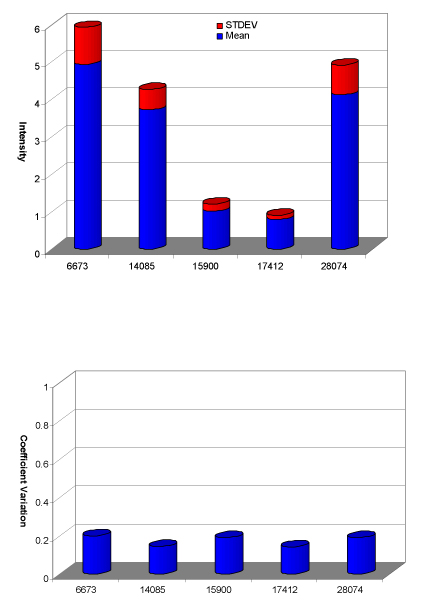
Demonstration of reproducibility of the SELDI experiments in liver cancer and liver toxicity study. The reproducibility of SELDI experiments was measured by the consistency of expression levels (peak intensities in spectra) of the five common proteins appearing in all 144 quality control samples used in the liver cancer and liver toxicity study. The numbers on the x-axes are the m/z values of peaks (in KDa.). (A) The average intensities of the five peaks in the 144 spectra are represented by the blue cylinders and the corresponding standard deviations depicting the variations in the 144 spectra are shown in red cylinders. (B) The coefficient of variation (CV), which is used to measure the precision of the peak intensity common in the 144 spectra from the set of SELDI experiments, is depicted as blue cylinders. All CVs are less than 0.2, which is considered acceptable reproducibility in SELDI.